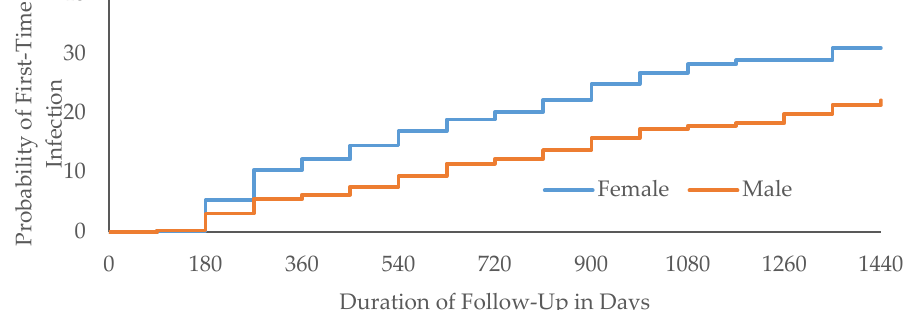
Figure 2. Time (days) to incident chlamydia.